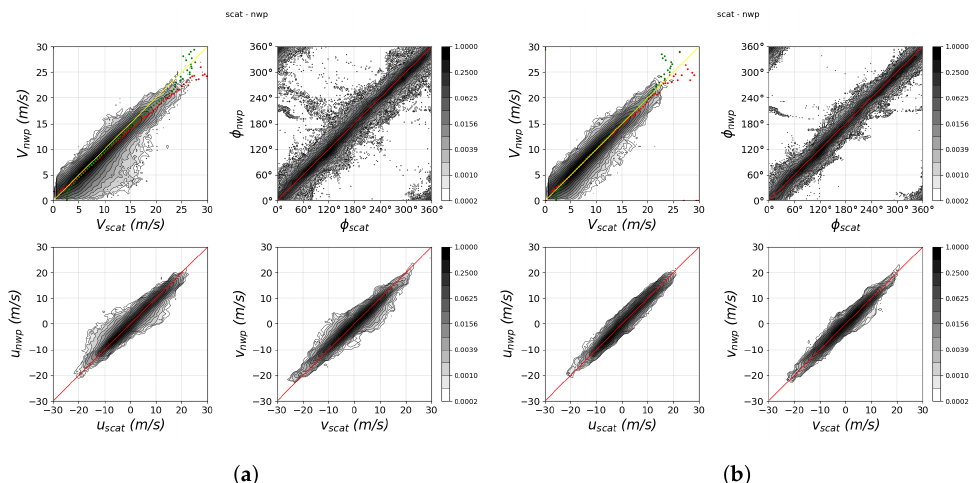
Figure 16. Ku-band ascending orbits: contoured wind speed, wind direction (wind speed > 4 m/s), u/v components histograms of retrieved winds vs. ECMWF winds, data from 1 November 2022–3 November 2022: ( a ) no NOC, ( b ) NOCant+0.15dB with QC. In the wind speed contour, the red dotted line is the average ECMWF wind speed, the green dotted line is the average WindRAD wind, and the yellow straight line is the